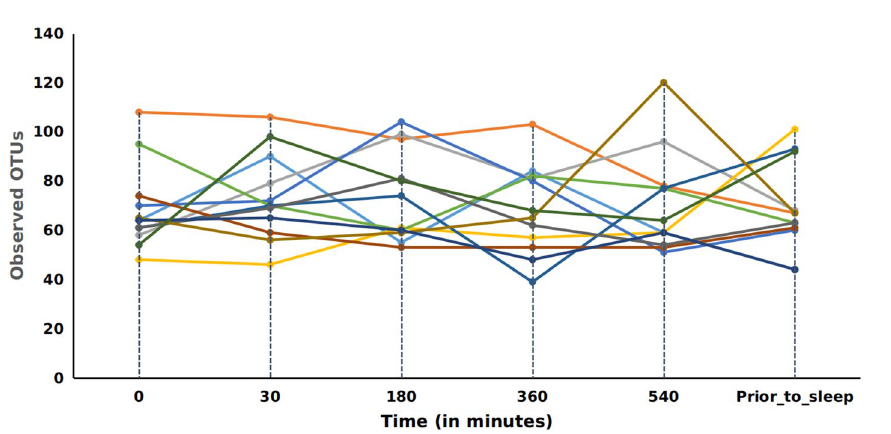
Figure 2. Observed Operational Taxonomic Units (OTUs) over time. OTUs are shown per subject as delineated by individual lines. X-axis units are shown as minutes post wake per individual.